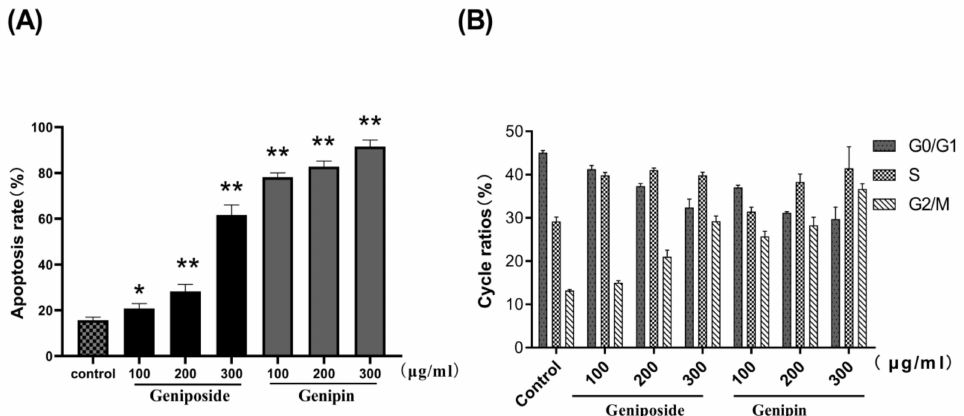
Figure 6. Bar diagrams showing percentage apoptosis and cell cycle. ( A ) Apoptosis diagram. ( B ) Cell cycle diagram. Values are presented as mean ± SD, n = 3. * p < 0.05 and ** p < 0.01 vs. control